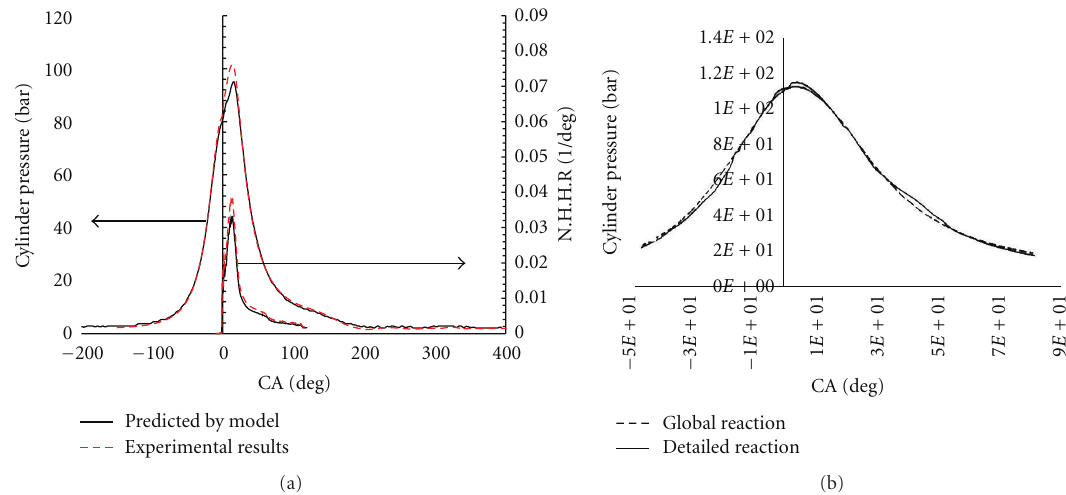
Figure 2: (a) Numerical and experimental results of cylinder pressure and normalized heat release rate and (b) calculated cylinder pressure (volume mean).